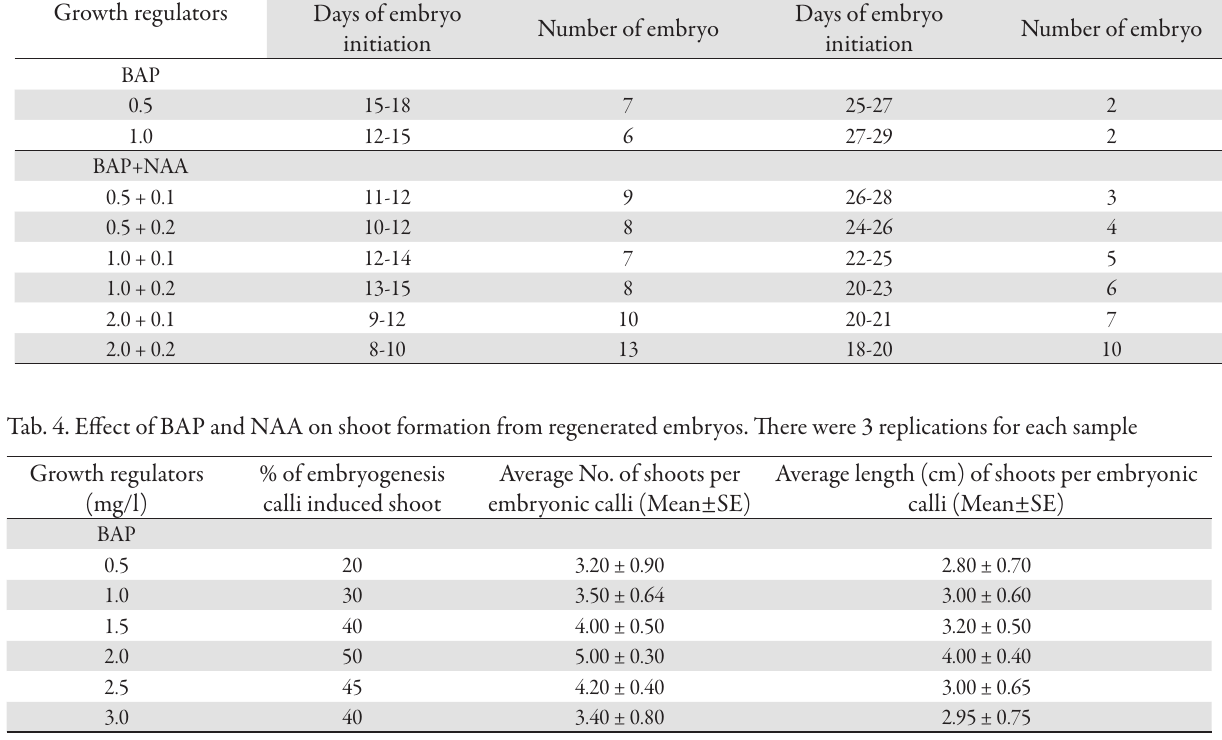
Tab. 3. Formation of somatic embryo from isolated cells derived callus. There were 3 replications for each sample Growth regulators